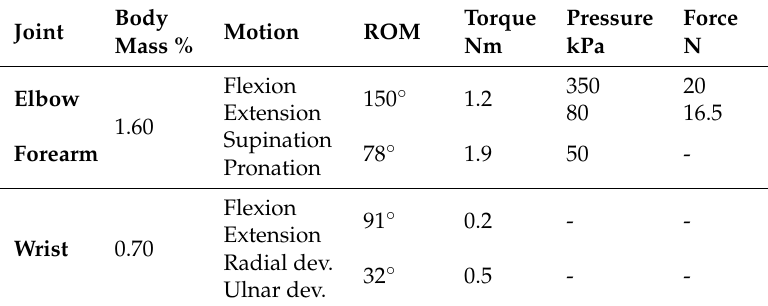
Table 2. Collected values for SWD.